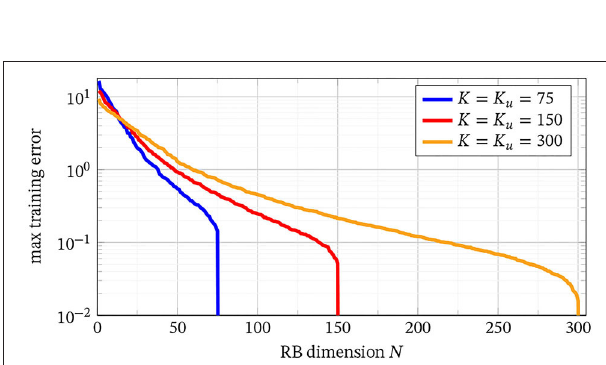
1 N ( µ ) for different time train